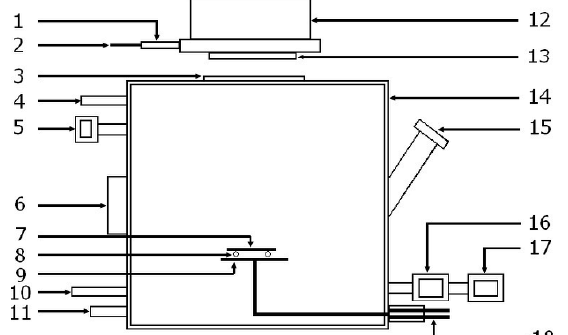
Fig. 1 . Schematics of the setup used for laser depo- sition. 1) beam expander, 2) optical fiber that deliv- ers the laser beam 3) laser entry port, 4) argon feed- through, 5) vacuum throttle valve, 6) view port, 7) graphite substrate, 8) alumina rods, 9) water-cooled copper induction coil heating element, 10) MKS baratron pressure transducer, 11) thermocouple vacuum gauge, 12) HurryScan 30, 13) F-theta lens, 14) water-cooled vacuum chamber, 15) view port, 16) turbo pump, 17) mechanical pump, 18) RF power supply.